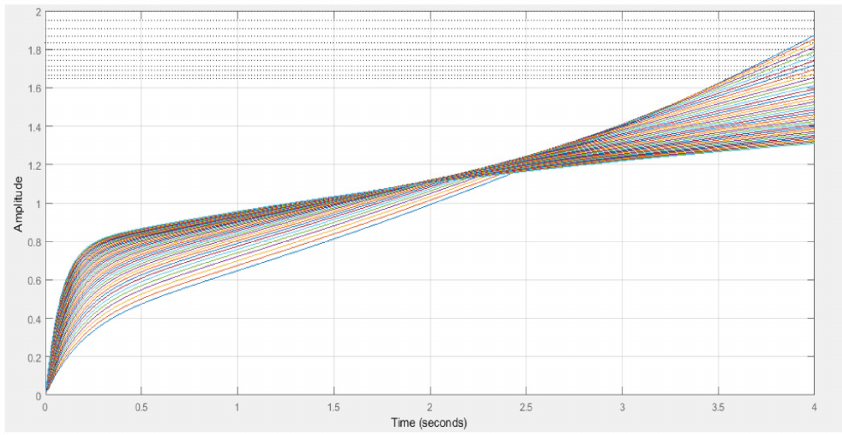
Figure 11. Step response of uncompensated 41 bus Nigerian 330 kV